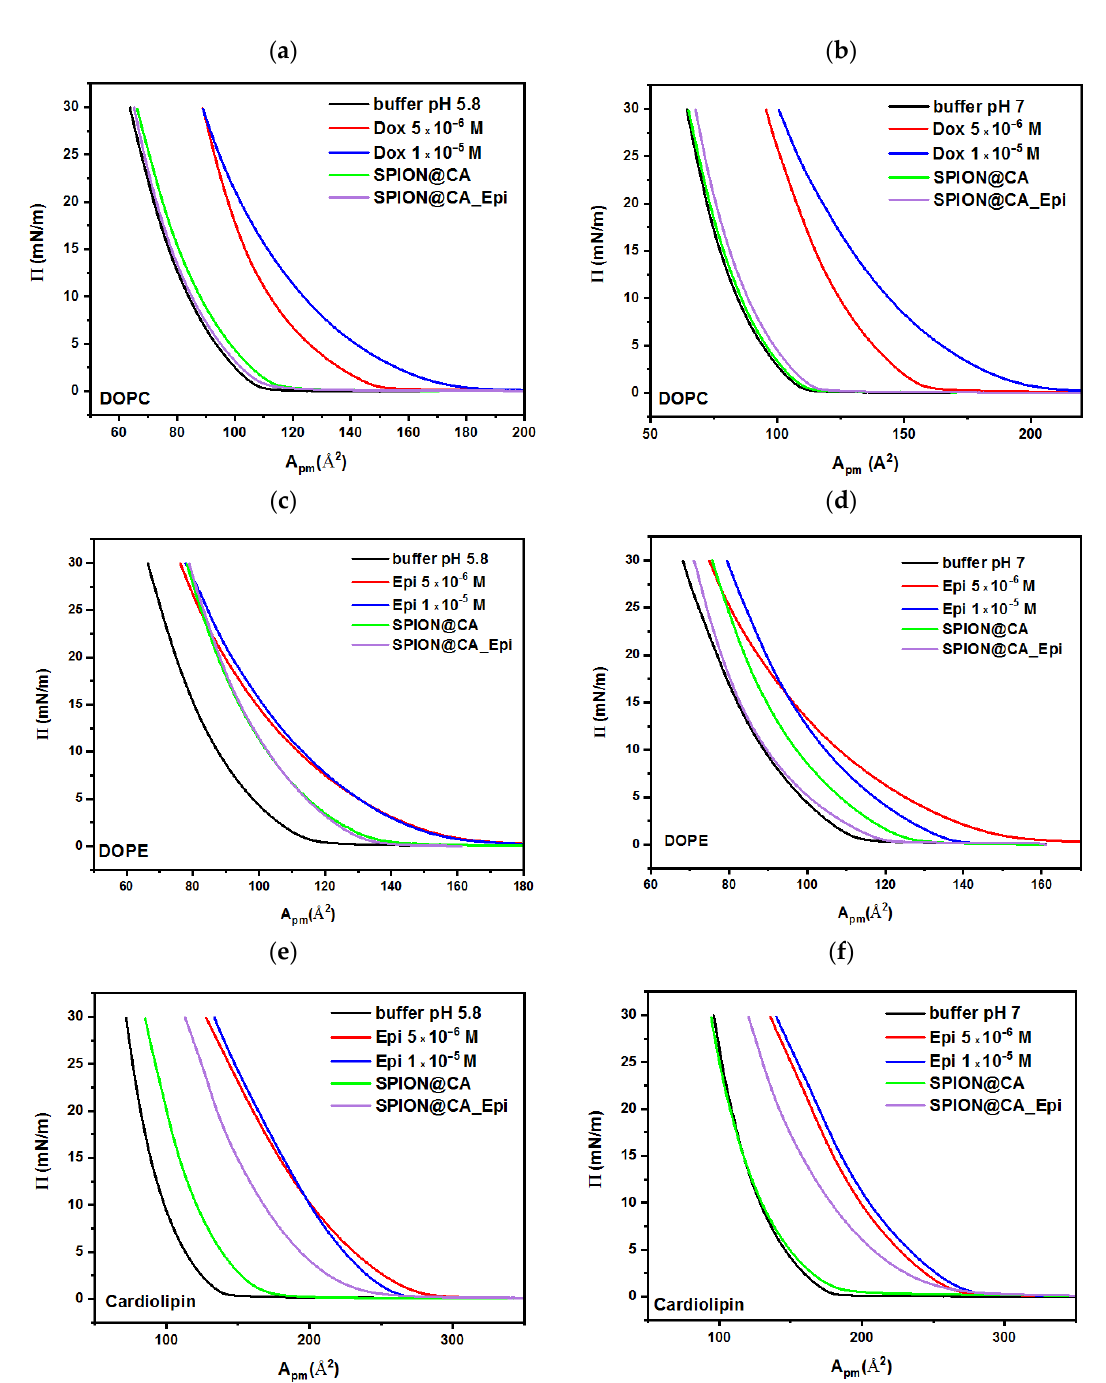
Figure 7. Langmuir isotherm for lipid ( a , b ) DOPC, ( c , d ) DOPE, and ( e , f ) cardiolipin on phosphate buffer as a subphase with the addition of doxorubicin at two different concentrations, SPION@CA, and SPION@CA_Epi. The left column shows the results obtained at pH 5.8, while the right column presents the isotherms recorded at pH 7.